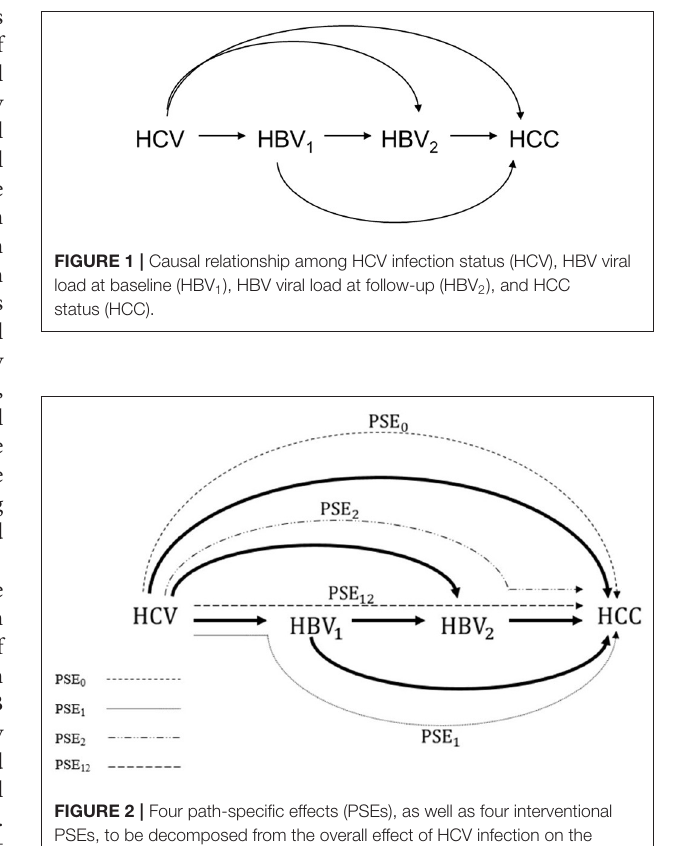
FIGURE 2 | Four path-specific effects (PSEs), as well as four interventional PSEs, to be decomposed from the overall effect of HCV infection on the incidence of HCC. PSE 1 : the path through the HBV 1 only; PSE 2 : the path through the HBV 2 only, PSE 12 : the path through HBV 1 which further impacts HBV 2 ; and PSE 0 : the path not through HBV 1 or HBV 2 . PSE, path-specific effect; HCV, hepatitis C virus; HBV, hepatitis B virus; HCC, hepatocellular